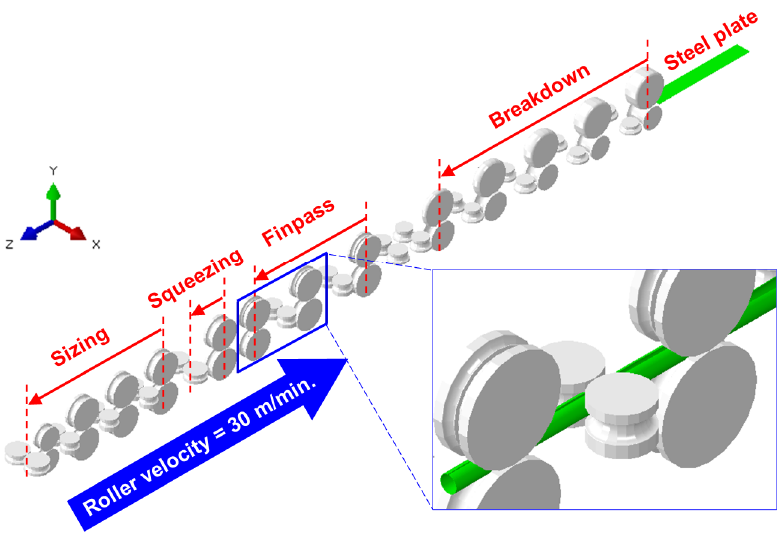
Figure 2. Simulation of the manufacture process using a three-dimensional finite element method.